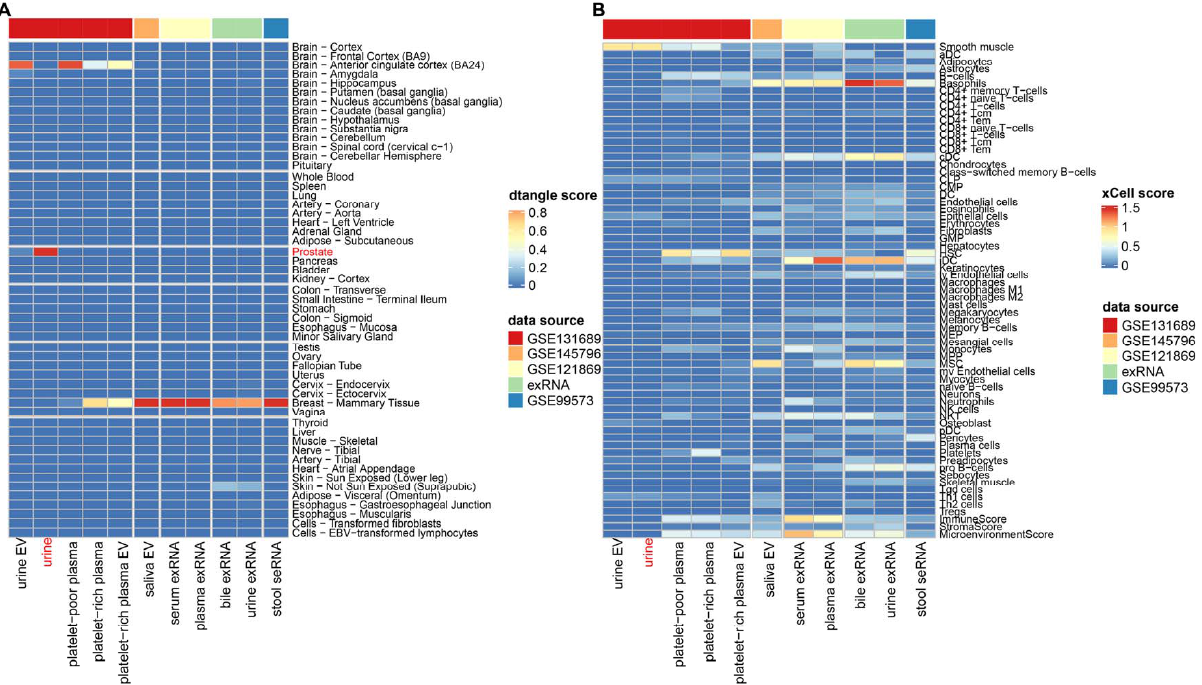
Figure 2. Estimated mixture components of biofluids. ( A ) Heatmap describing the dtangle estimated tissue composition of each biofluid type. ( B ) Heatmap describing the 67 cell-type-specific enrichment scores of each biofluid